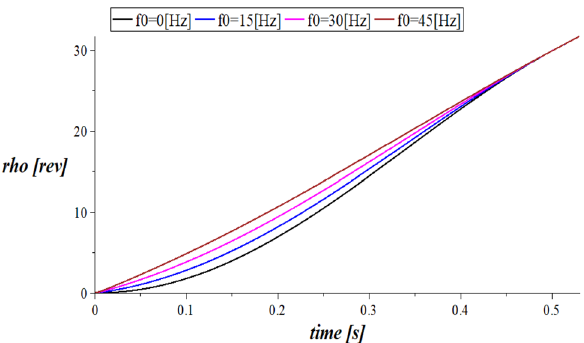
Fig. 19 Rho angle of the rotating electric current vector, obtained as a solution of transformed (14) equations for R,L circuit, in case of voltage f v ( t ) frequency increase from f 0 = 0,15,30,45 (Hz) to f